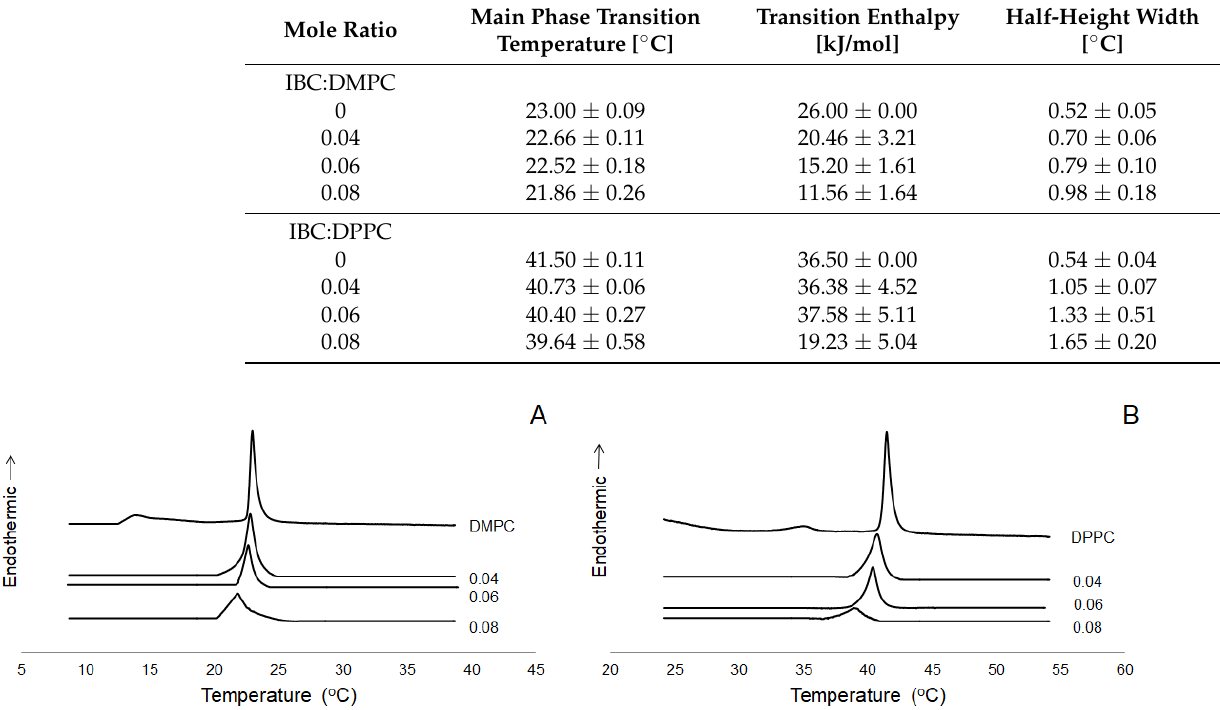
Figure 5. Thermograms of DMPC and IBC-DMPC mixtures ( A ), and DPPC and IBC-DPPC mixtures ( B ). Numbers in the figure represent IBC:lipid mole ratios. The thermograms were normalized to an equal amount of lipid for each profile.